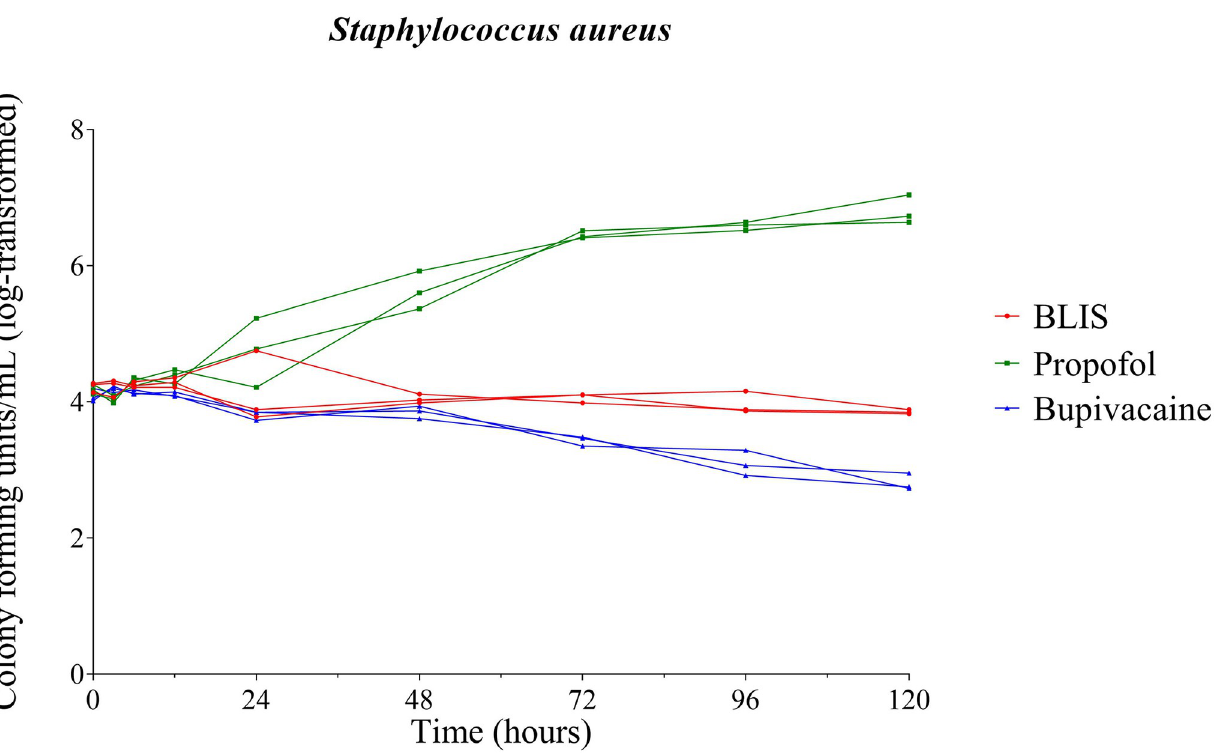
Fig 3. Growth dynamics of Staphylococcus aureus . Growth of inoculated Staphylococcus aureus over time in bupivacaine liposomal injectable suspension (BLIS), propofol, and bupivacaine 0.5%. Each line represents an individual vial; red lines represent BLIS, green lines represent propofol, and blue lines represent 0.5%